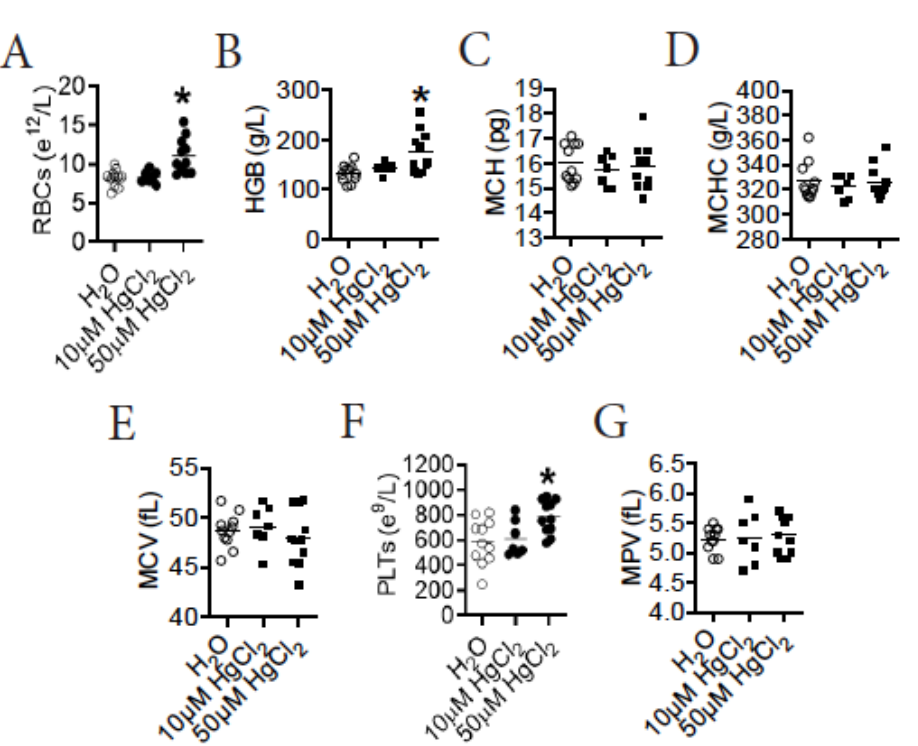
Figure 1. HgCl 2 increases the number of erythrocytes and platelets in the blood of B10.S mice. B10.S mice were treated with 10 µ M or 50 µ M HgCl 2 for 4 w, and RBT was performed thereafter. ( A ) The concentration of RBCs. ( B ) The concentration of HGB. ( C ) The MCH. ( D ) The MCH con- centration (MCHC). ( E ) The MCV. ( F ) The concentration of platelets (PLTs). ( G ) The MPV. Each dot represents one mouse, and a total of 7 to 11 mice were used for each group. Asterisk indicates a significant difference compared to the counterpart control group. p < 0.05 was considered as the level of significant